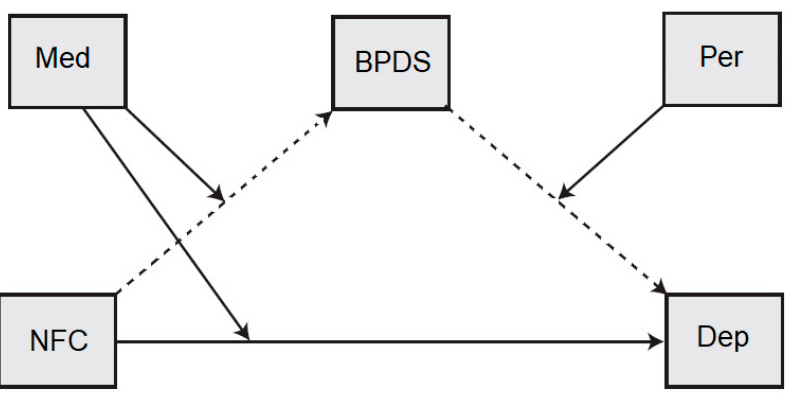
Figure 5. The multiple moderated mediation analysis (Model 22). BPDS = borderline personality disorder symptoms, NFC = negative family climate, Dep = Depression, Med = meditation, Per = Perseverance, Single-headed arrow from the variable in rectangular boxes represents path coefficients or direct effect. Solid arrow indicates moderation; Dashed arrow indicates mediation, and indirect pathway. Solid lines are direct effect; Dot lines are indirect effect.